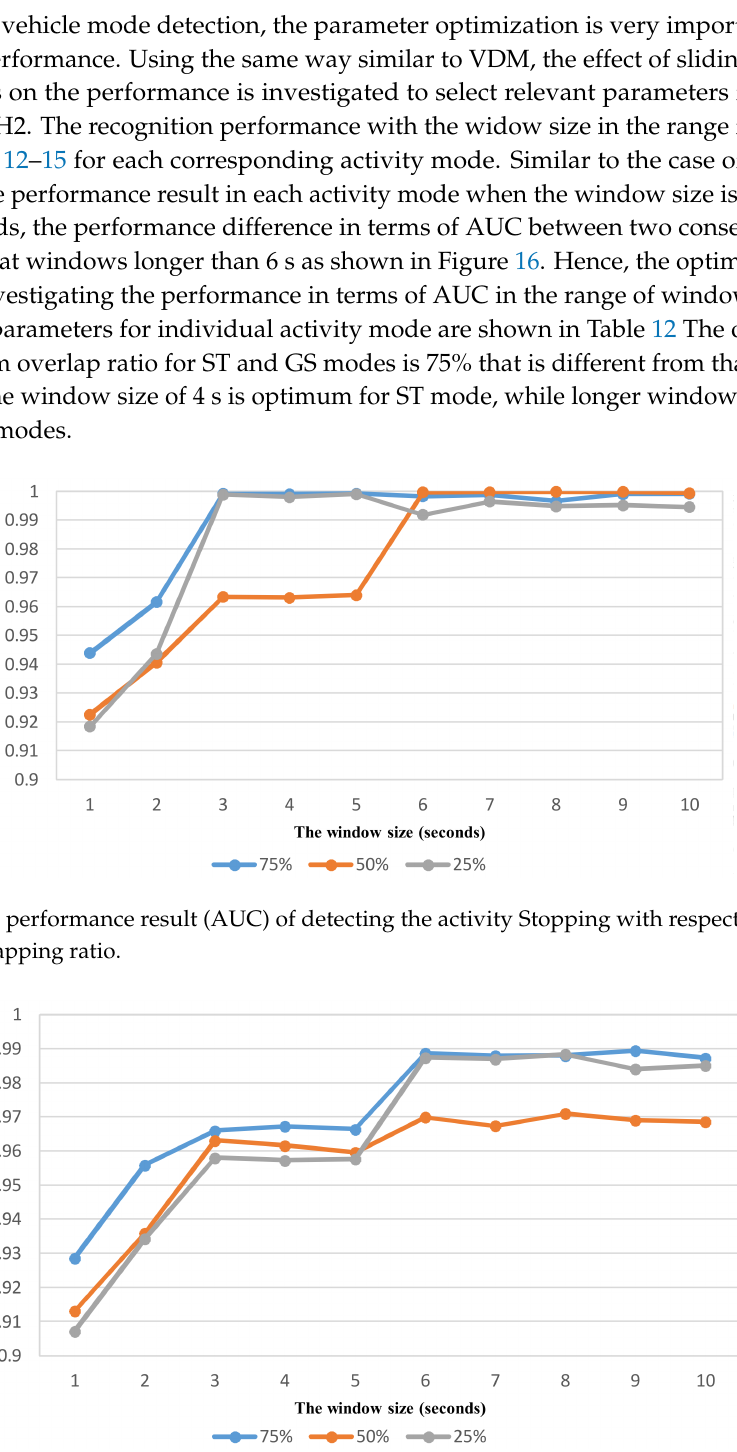
Figure 13. The performance result (AUC) of detecting the activity Going with respect to window size and overlapping